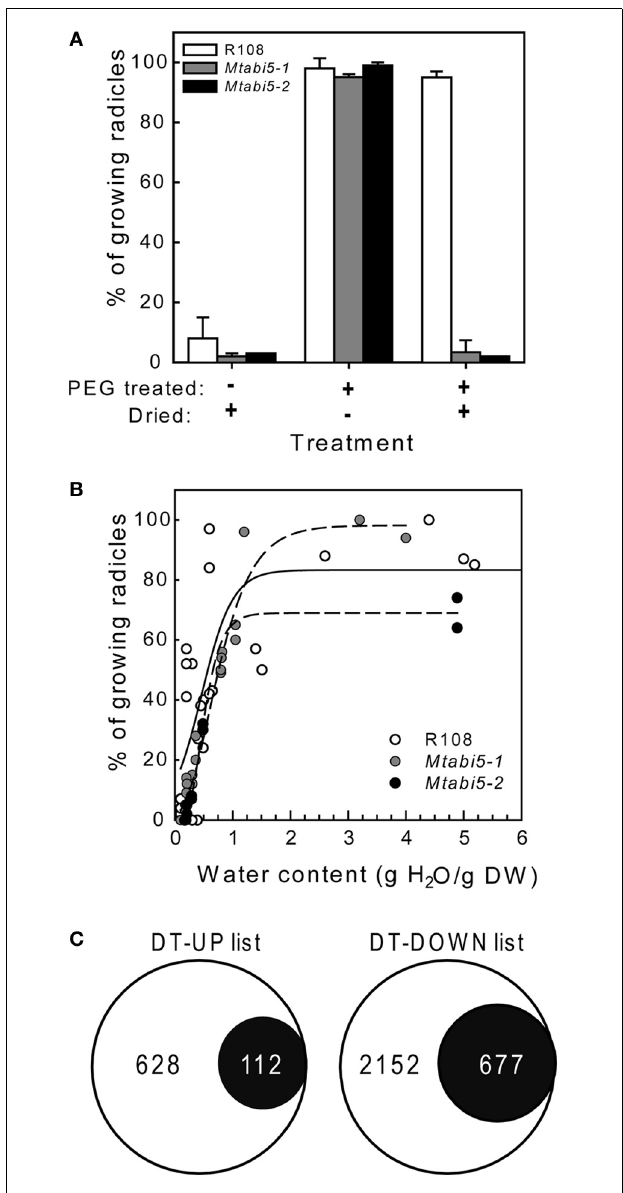
FIGURE 4 | Desiccation tolerance is not re-established during PEG treatment in germinated Mtabi5 seeds. (A) Percentages of desiccation tolerance of 2.7mm long protruded radicles from germinated wild-type and Mtabi5 seeds. Seeds were dried at 42% relative humidity (RH) for 3 days before or after a PEG treatment consisting in incubating seeds for 3 days in a polyethylene glycol (PEG) solution ( − 1.7MPa) at 10 ◦ C. Data represent the average ( ± SE) of three independent experiments of 50 seeds. (B) The effect of drying at 42% RH at the indicated water content on survival of 2.7mm long protruded radicles of germinated seeds. Each data points represent 30 seeds from three independent experiments. (C) Euler diagrams showing the number of transcripts in the DT-UP and DT-DOWN list ( Figure 1 ) that do not change significantly in germinated Mtabi5 radicles after PEG incubation.